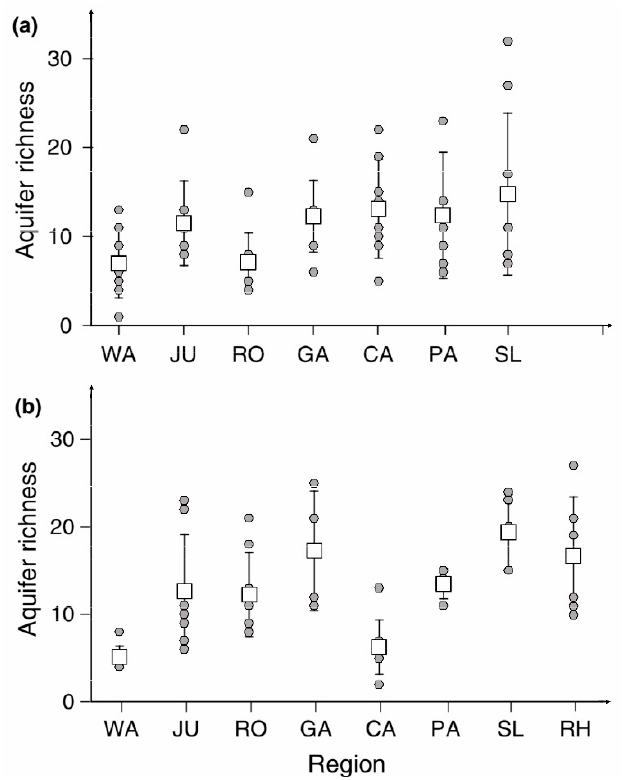
of latitudinal bands. From Zagmajster et al. [51]. With permission of Springer Nature.